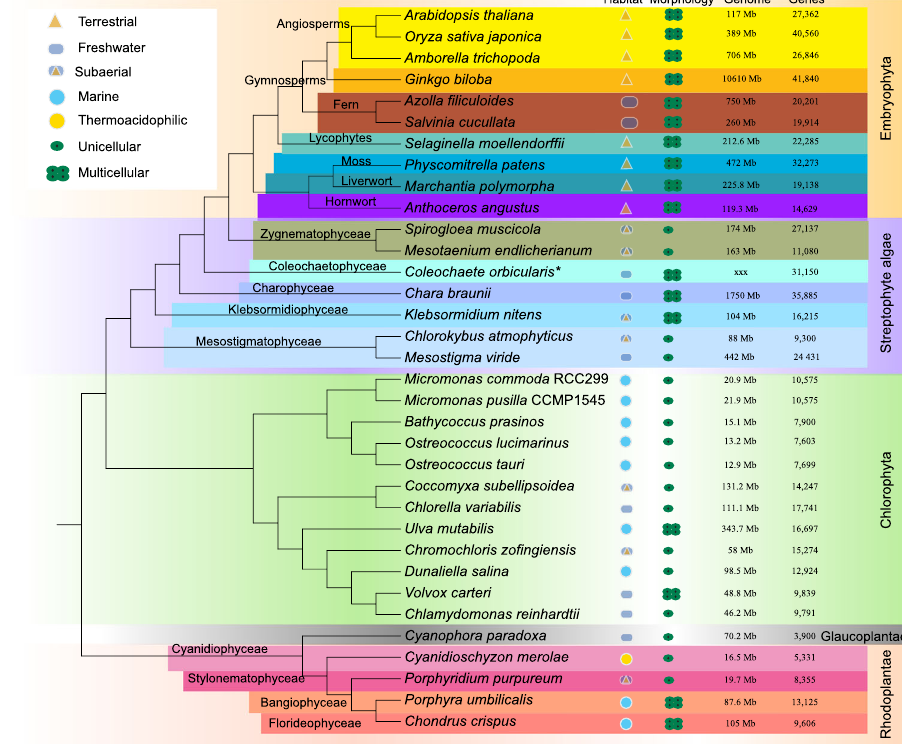
Fig. 1 Phylogeny of Archaeplastida showing the species included in this study. For each species, the genome size and total gene number as well as habitat and morphological characteristics are also indicated. The tree was modi fi ed and compiled from refs. 10,23,40 . * denotes transcriptome